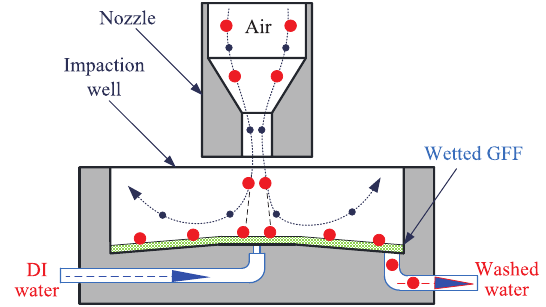
Fig. 3 Schematic diagram of the M-WINS (Le T.C. and Tsai C.J.,